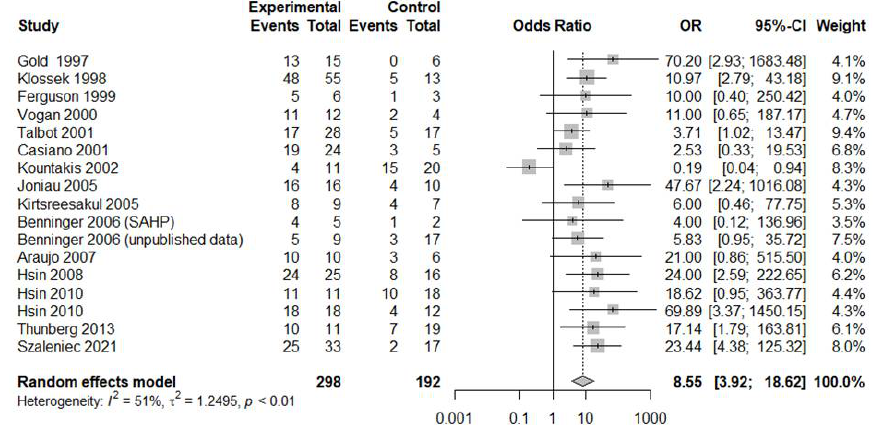
Figure 3. Forest plot of the diagnostic odds ratios of all studies [1,3,4,6–13,17–20].